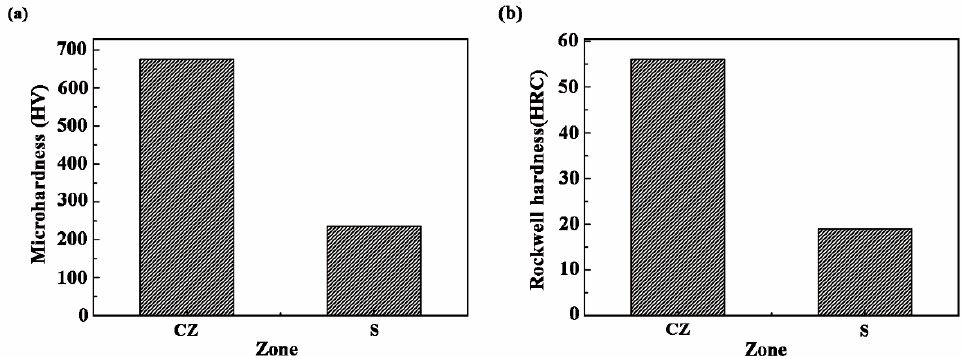
Figure 9. ( a ) Microhardness and ( b ) Rockwell hardness of the CZ and S.